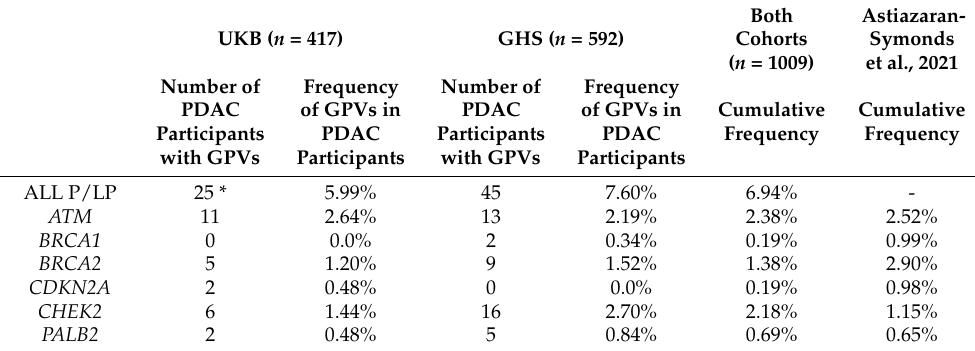
Table 1. Number and prevalence of heterozygotes for GPV for each cohort by gene. Number and Prevalence Number and Prevalence Number and Prevalence (%, in Parentheses) of (%, in Parentheses) of (%, in Parentheses) of Heterozygotes for GPV Heterozygotes for GPV Heterozygotes for GPV in Both Cohorts in GHS ( n = 175,449) in UKB ( n = 200,619) ( n = 376,068) ATM 839 (0.42%) 885 (0.50%) 1724 (0.46%) BRCA1 223 (0.11%) 356 (0.20%) 579 (0.15%) BRCA2 710 (0.35%) 717 (0.40%) 1427 (0.38%) CDKN2A 137 (0.07%) 47 (0.027%) 184 (0.05%) CHEK2 1619 (0.80%) 2987 (1.69%) 4606 (1.22%) PALB2